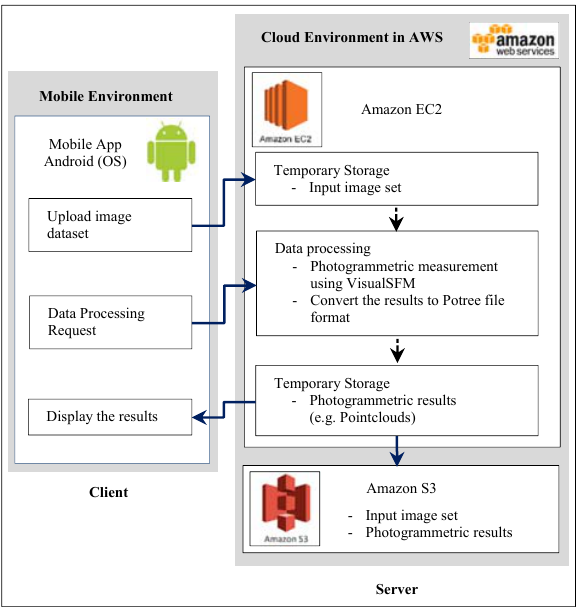
Figure 3. Overview of the mobile and cloud computing photogrammetric measurement